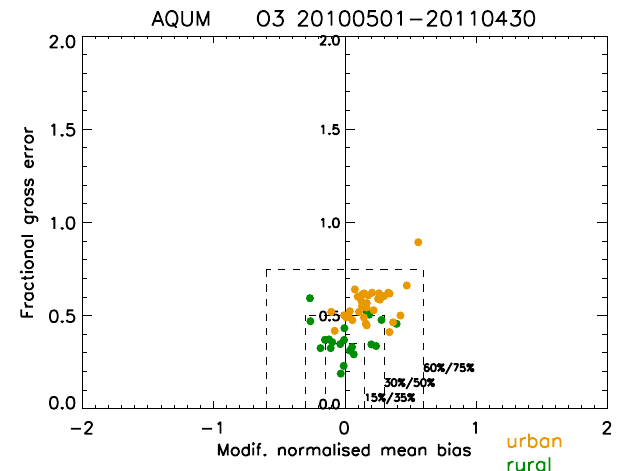
Fig. 1. Soccer plot showing fractional gross error as a function of the modified normalised mean bias relative to hourly observations of ozone for the period 1 May 2010 to 30 April 2011. Urban back- ground and suburban sites are shown in orange, while remote and rural sites are given in